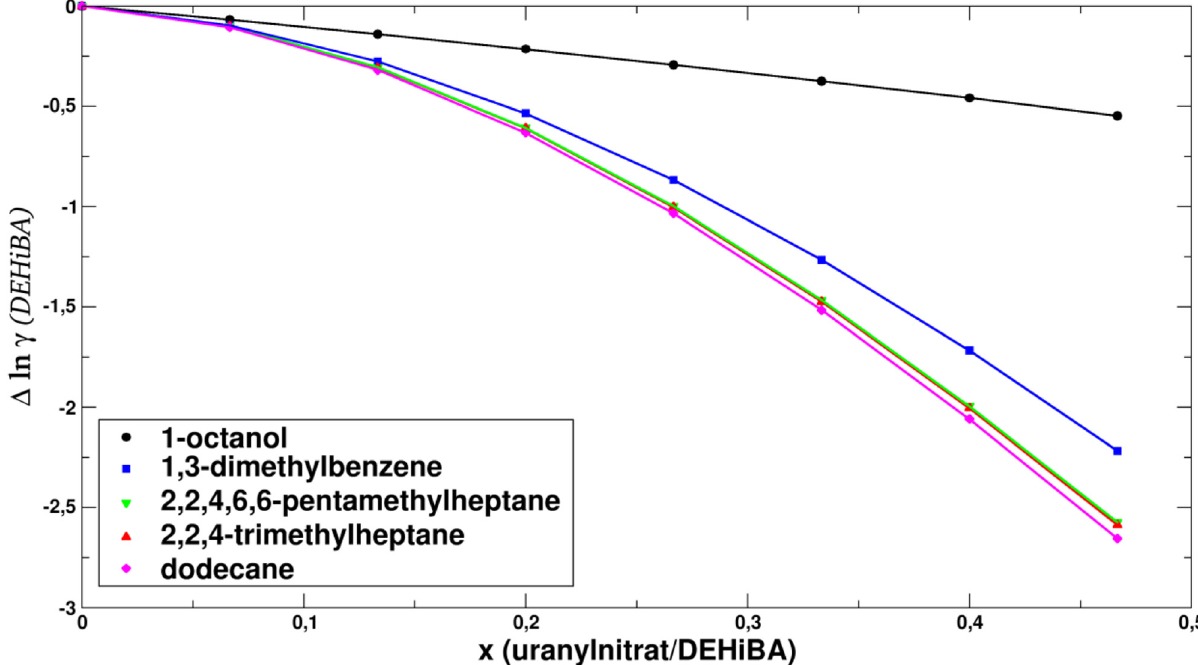
Fig. 9. Deviation of COSMO-RS predicted logarithmic activity coef fi cients of DEHiBA in different diluents with uranyl nitrate from the corresponding reference systems without uranyl nitrate. All calculations were performed on the BP-TZVPD-FINE level at a temperature of 25 ° C with 4 conformers of DEHiBA and extractant concentrations of 1.5 mol DEHiBA per liter of diluent.